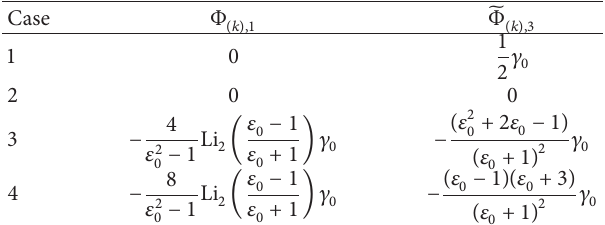
Table 3: The coefficients Φ (𝑘),1 and for an insulator with